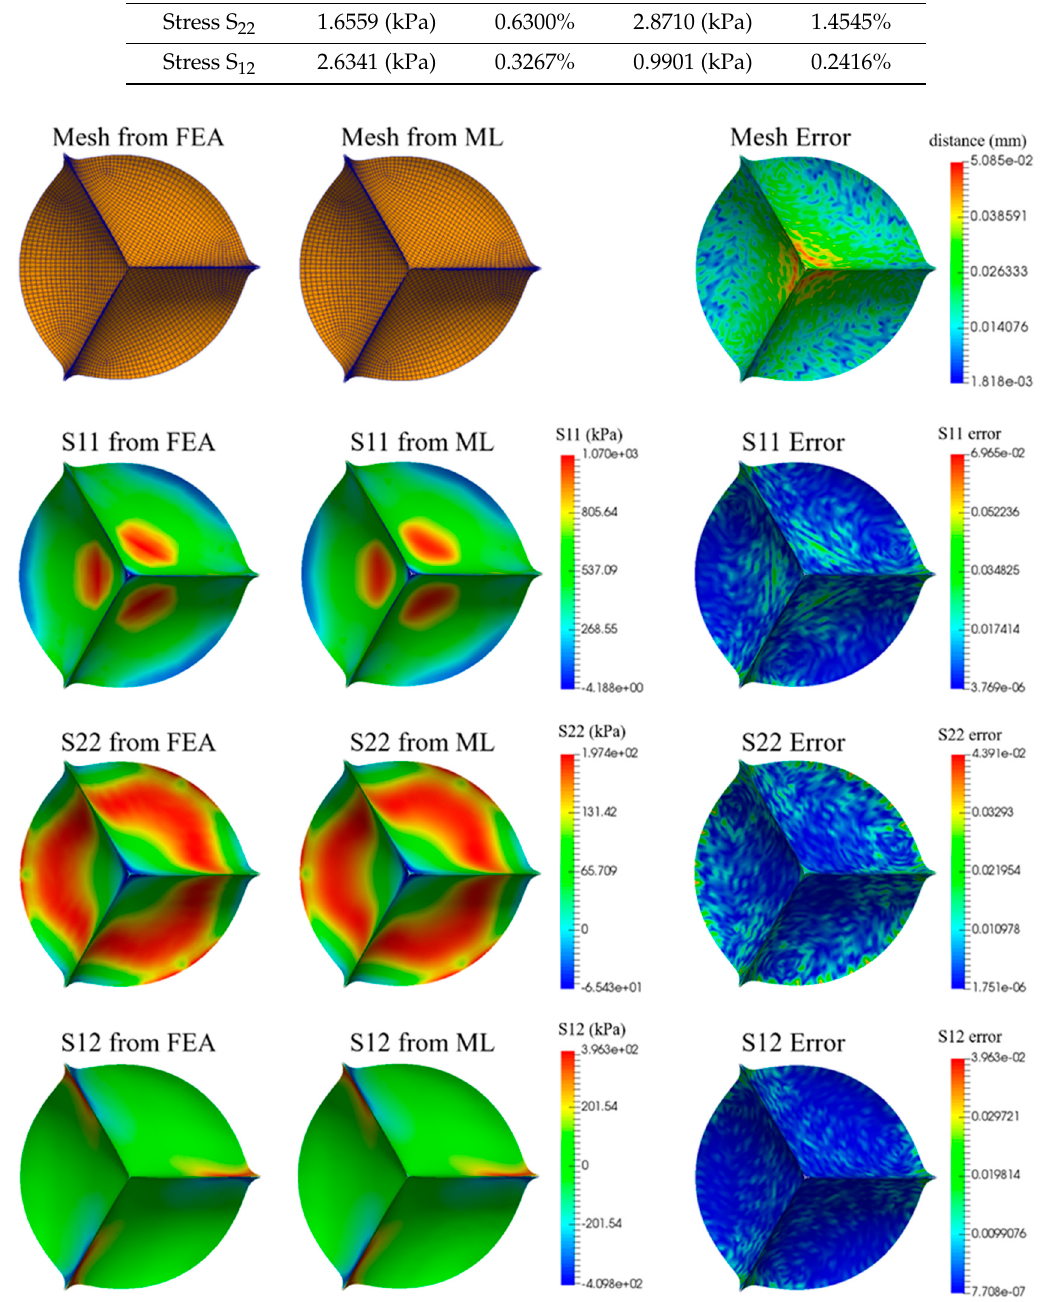
Figure 7. Comparison of deformed shape (i.e., mesh, distance errors are color-coded) and stress distributions (three components: S11, S22, S12) from FEA and ML for one representative example. The relative stress error at node- n is defined as 𝑆(cid:4634)(𝑛) |max {𝑆} − min {𝑆}|⁄ , where 𝑆(cid:4634)(𝑛) is from the ML model.